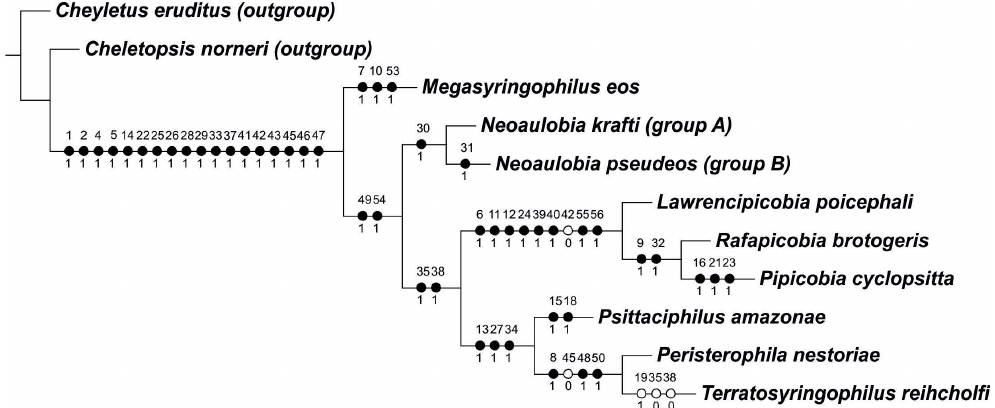
Figure 3. Phylogenetic tree of the syringophilid genera associated with parrots.